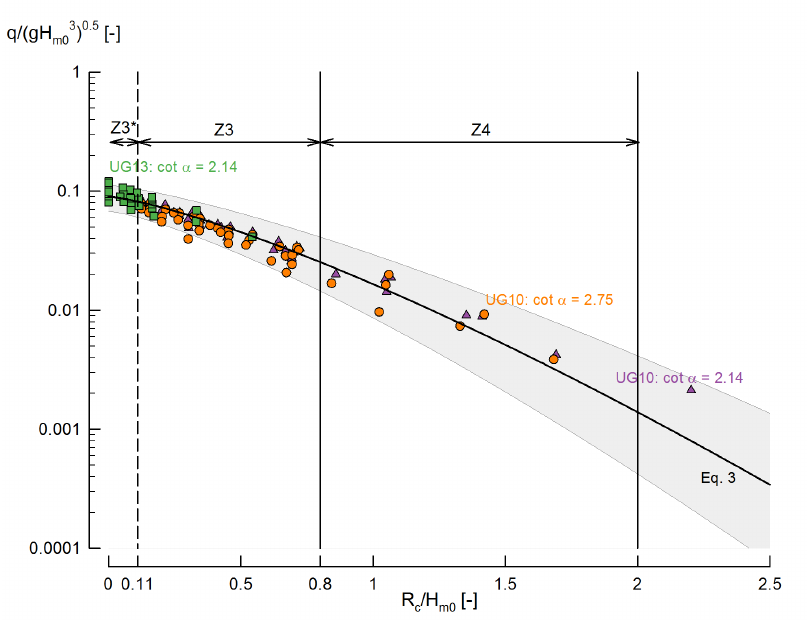
(cid:113) gH 3 as a function of the relative crest m 0